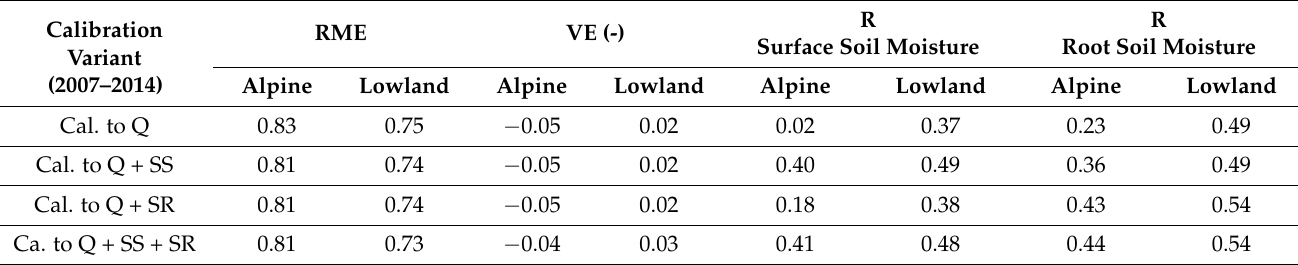
Table 3. Medians of the runoff model efficiency values, runoff volume error, and correlation coefficients between simulated and measured surface and root soil moisture for the two groups of catchments (71 Alpine and 138 Lowland catchments) in the calibration period